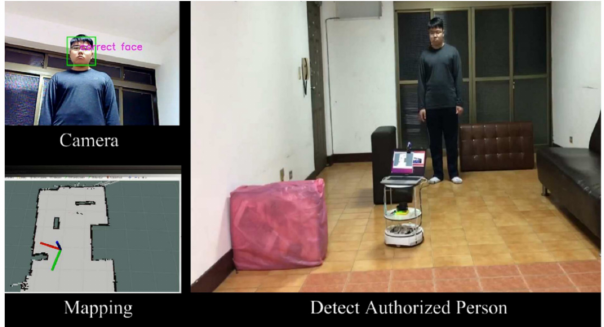
Figure 34. Face recognition of authorized target in first indoor environment.